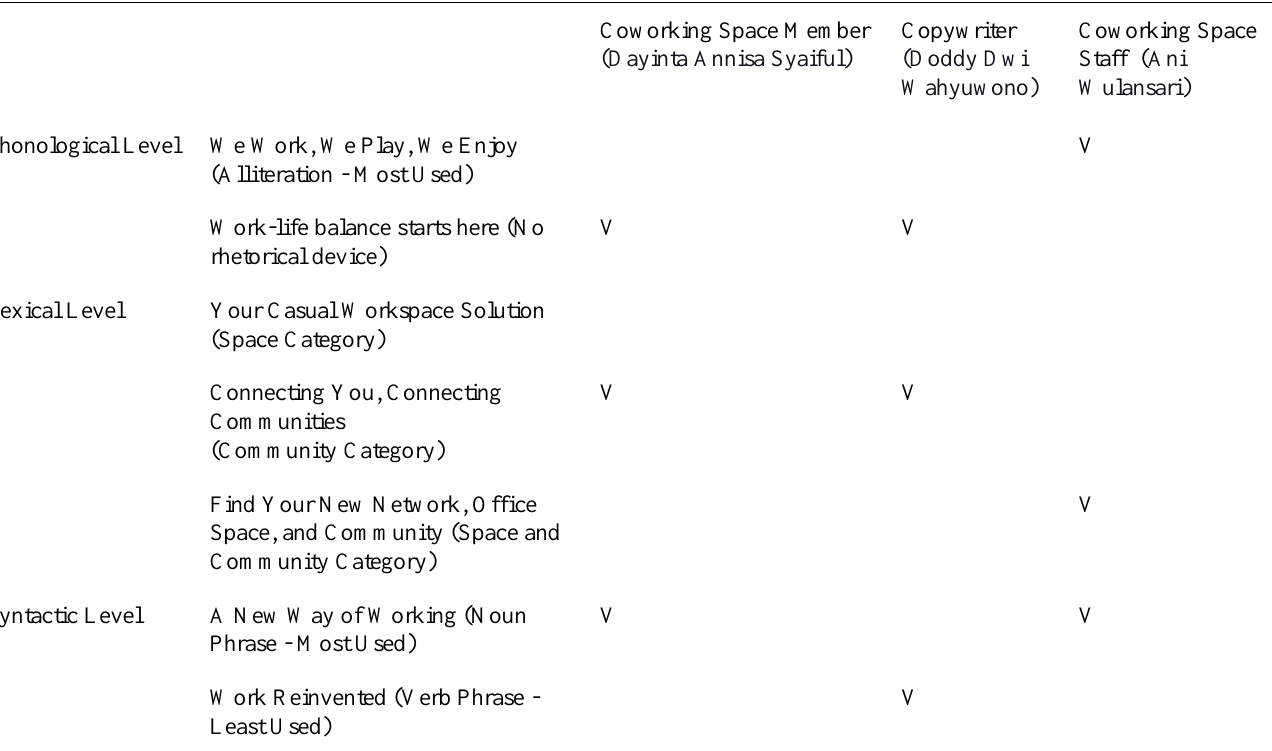
TABLE 5 | Interviewees‘ preferences of coworking space